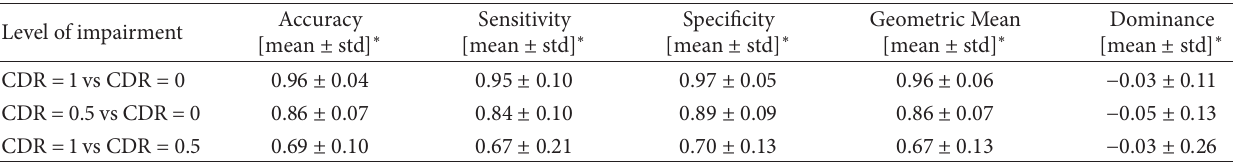
Table 7: Performance of ML (accuracy, sensitivity, specificity, GM, and Dominance) in the classification of CDR = 1 versus CDR = 0.5, CDR = 0.5 versus CDR = 0 and CDR = 1 versus CDR = 0.5. Results were obtained using the feature reduction guided by the